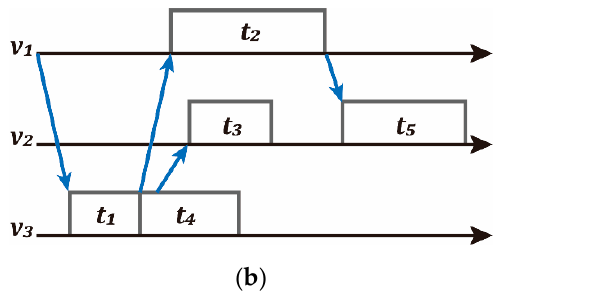
Figure 1. An example of task scheduling: ( a ) DAG representation of the application to be offloaded; ( b ) The Gantt chart of task executions offloaded by the Max ‐ Min; ( c ) The Gantt chart of task executions offloaded by the HEFT.